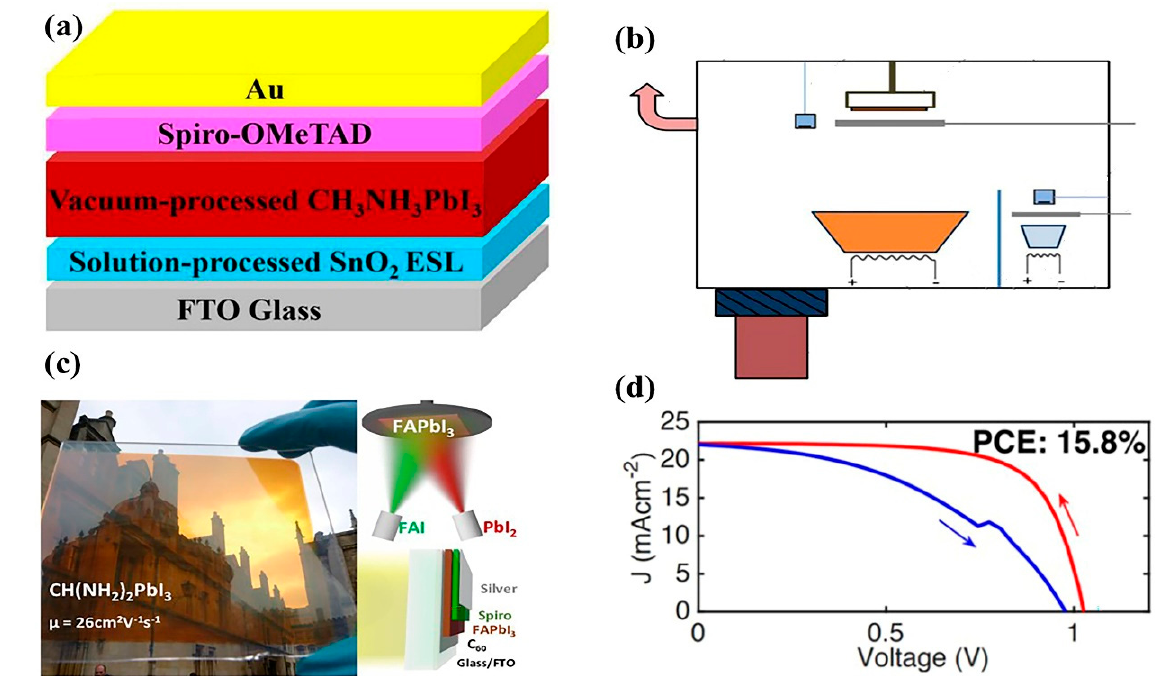
Figure 16. ( a ) The device structure of the PSC using SnO 2 ETL processed at different temperatures [146]. Copyright 2015 Royal Society of Chemistry. ( b ) Schematic diagram of the hybrid deposition method [147]. Copyright 2015 Royal Society of Chemistry. ( c ) Photograph of thermally evaporated large scale FAPbI 3 film on a glass substrate. Scheme of the film deposition method and the device architecture. ( d ) J–V curves of the FAPbI 3 PSC under different scan directions ( c , d ) [43]. Copyright 2017 American Chemical Society.